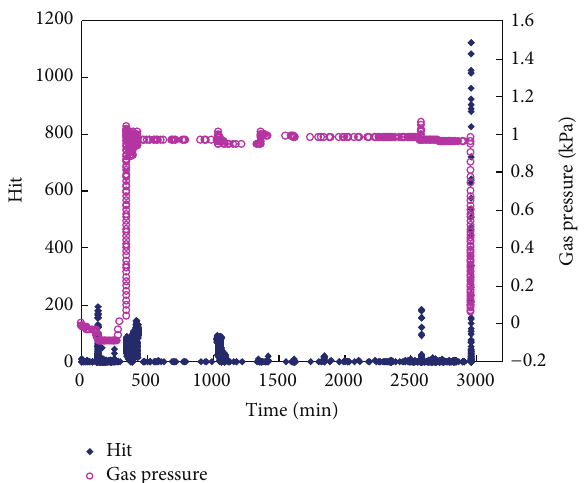
Figure 4: Monitoring data of gas pressure and Hit by acoustic emission during experiment (gas pressure − 1kPa and load pressure 3.6 MPa). 0–500 min: gas injection; ∼ 2500 min: load application; ∼ 3000 min: